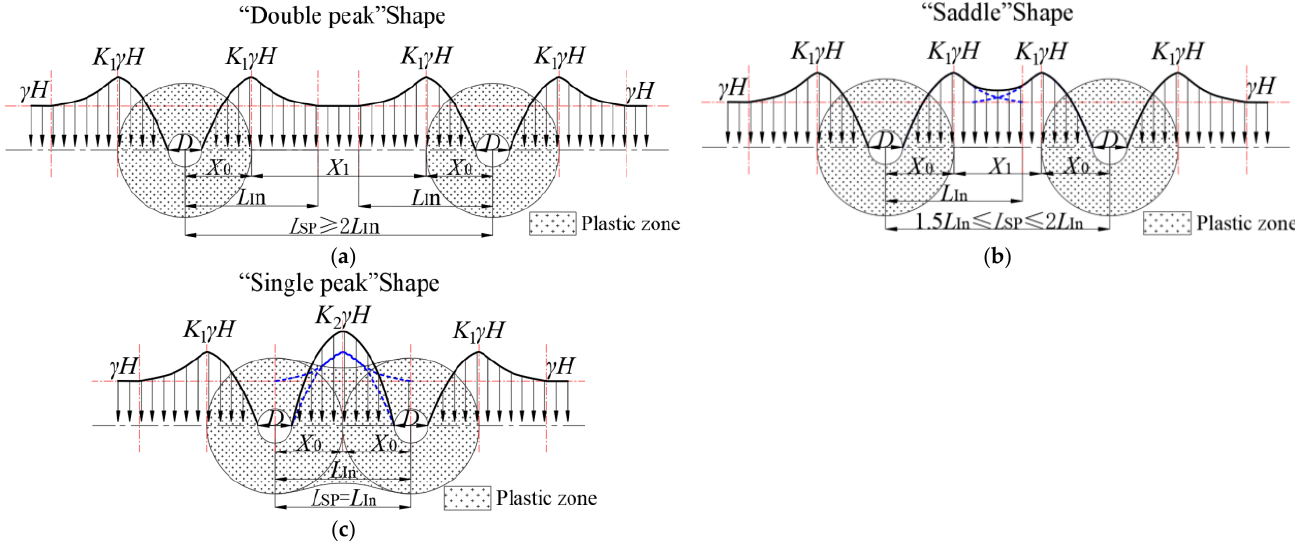
Figure 14. Analysis model of reasonable borehole spacing. ( a ) L SP ≥ 2 L In . ( b ) L SP ≥ 2 L In . ( c ) L SP ≥ 2 L In .